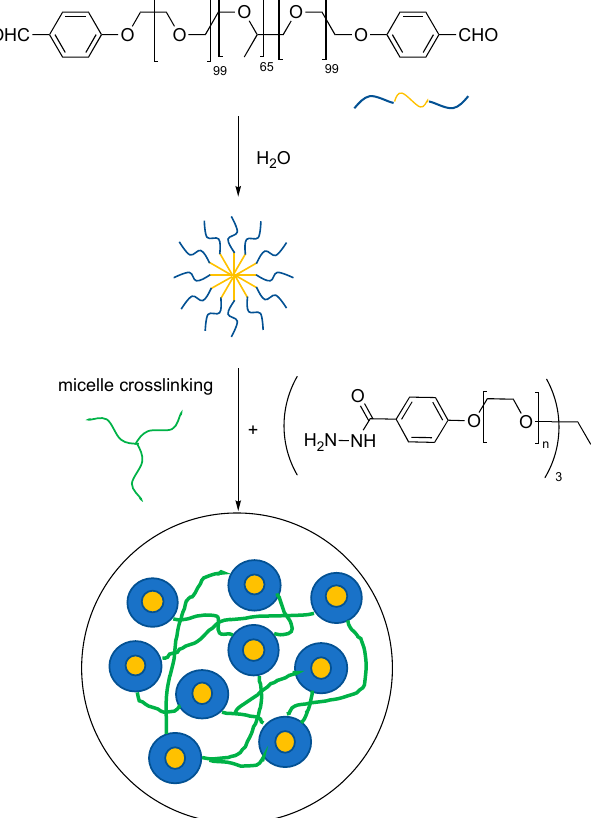
Figure 7. Dynamic covalent hydrogels with triblock copolymer micellization. Adapted and re-drawn from [33]. Yellow: hydrophobic block and/or domain. Blue: hydrophilic block and/or domain. Green: crosslinker.